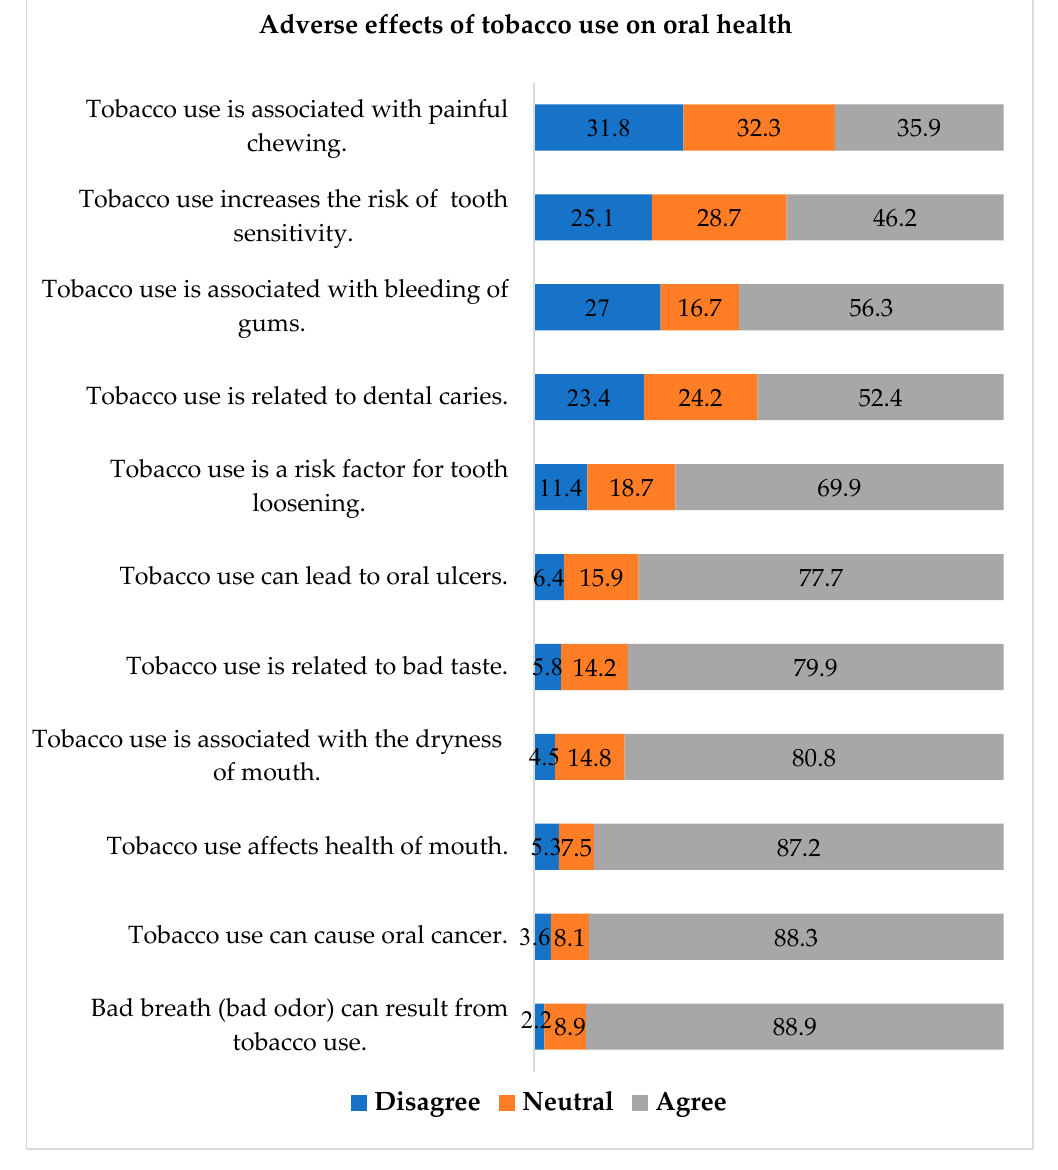
Figure 1. Dentists’ responses about the adverse effects of tobacco use on oral health. The majority of participants reported asking their patients about tobacco habits (86.6%), mentioning tobacco use in patient records (71.3%), and explaining the benefits of quitting smoking (79.9%). TCC should be a part of the dental curriculum was suggested by 70.2% of the participants and 64.3% were in the favor of banning tobacco products in Saudi Arabia. Less than half the sample (47.1%) referred patients to services/programs to help them quit tobacco use. In the study, 47.1% of dental professionals reported that adequate TCC training was not available and only 17.7% were confident to a greater extent to effectively offer TCC technique to their patients (Figure